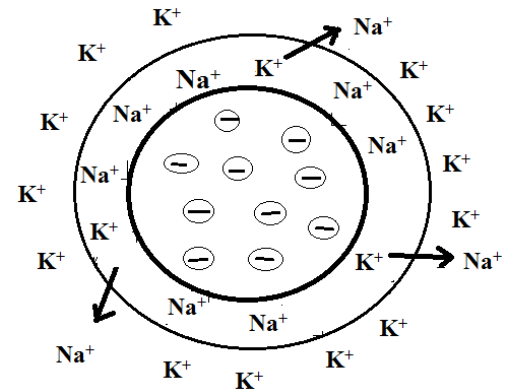
Figure 2. Schematic representation of an ion exchange